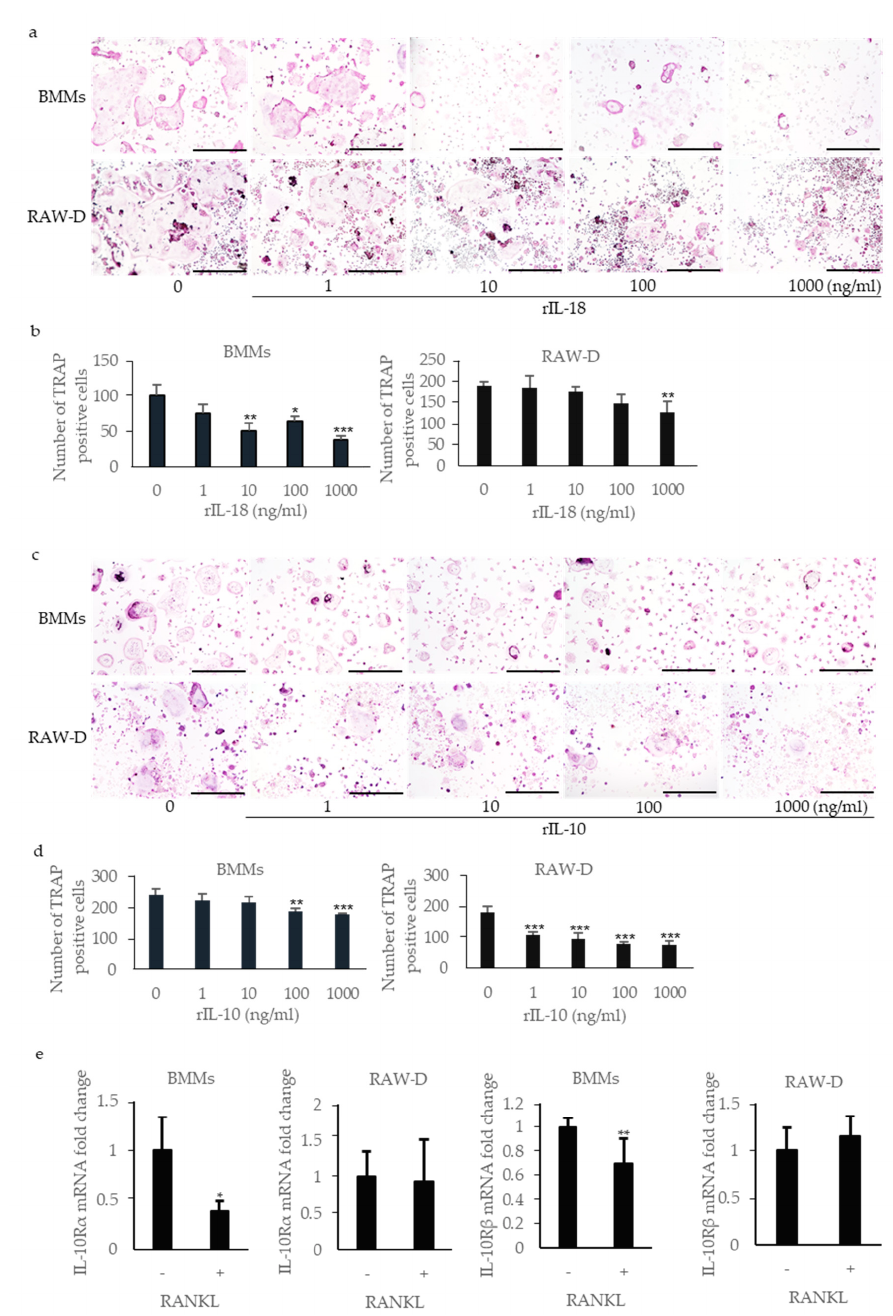
Figure 6. Effects of recombinant (r)IL-18 and rIL-10 on osteoclastogenesis. BMMs were incubated with 30 ng/mL M-CSF and 20 ng/mL RANKL for 48 h. Then, the cells were incubated for 24 h with the same concentration of M-CSF, RANKL, and rIL-18 ( a , b ) or rIL-10( c , d ). RAW-D cells were incubated with 20 ng/mL RANKL for 48 h. Then, the cells were incubated for 48 h with the same concentration of RANKL and rIL-18 or rIL-10. These cells were subjected to TRAP staining ( a , c ), and TRAP-positive cells with more than three nuclei were counted ( b , d ). Total RNA was extracted from the unstimulated and RANK-primed cells, and the relative expression of IL-10RA and IL-10RB mRNA was determined using quantitative reverse transcription–polymerase chain reaction (qRT–PCR) ( e ). Scale bar = 500 µ m. The differences between the groups were analyzed by one-way ANOVA followed by a Tukey test for multiple comparisons. The differences between two groups were analyzed using t -tests. * p < 0.05 ** p < 0.01 *** p < 0.001 compared with the control. BMM, bone marrow macrophage; M-CSF, macrophage colony-stimulating factor; TRAP, tartrate-resistant acid